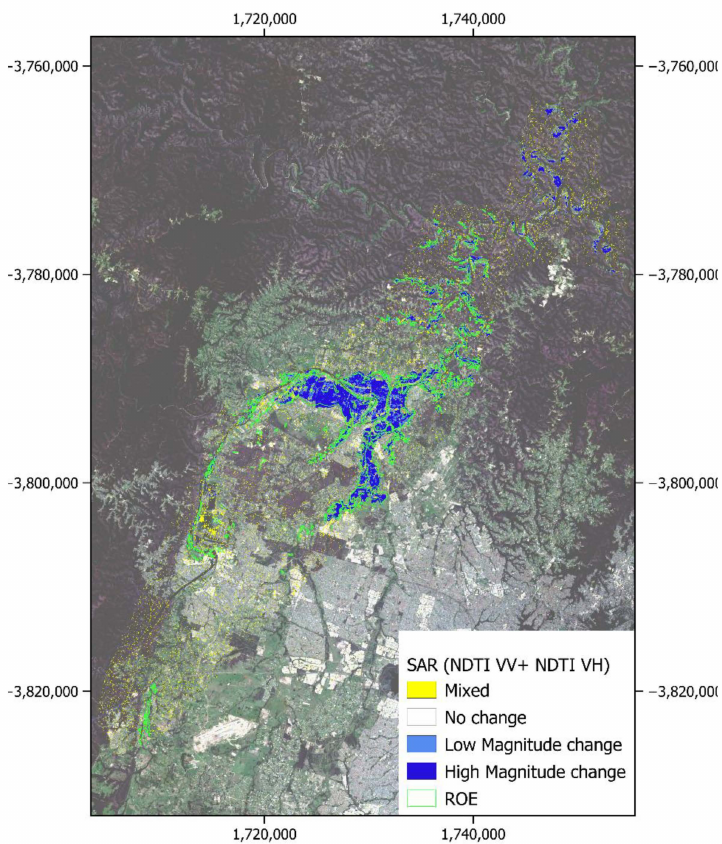
Figure 11. Flood-related change maps for the Richmond case study, obtained from the SAR module dataset, in comparison to the Reference Observed Event (ROE) [42] (coordinate reference system: WGS84/World Mercator).